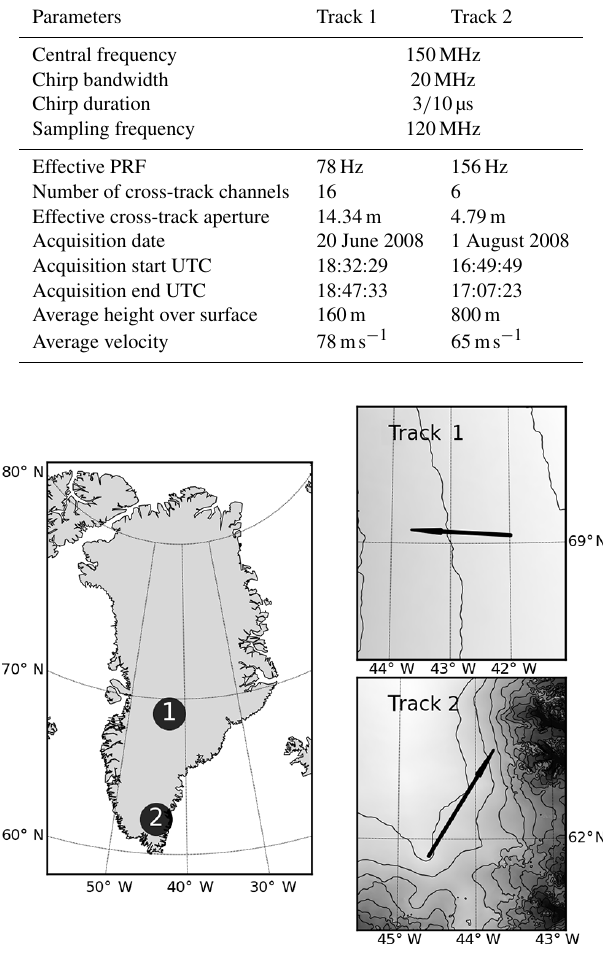
Figure 2. MCRDS surveys on a map. The map of Greenland is plotted using a stereographic projection with a central meridian of 41 ◦ W and a central parallel of 72 ◦ N. Isolines on maps correspond to a surface elevation change of 250m.